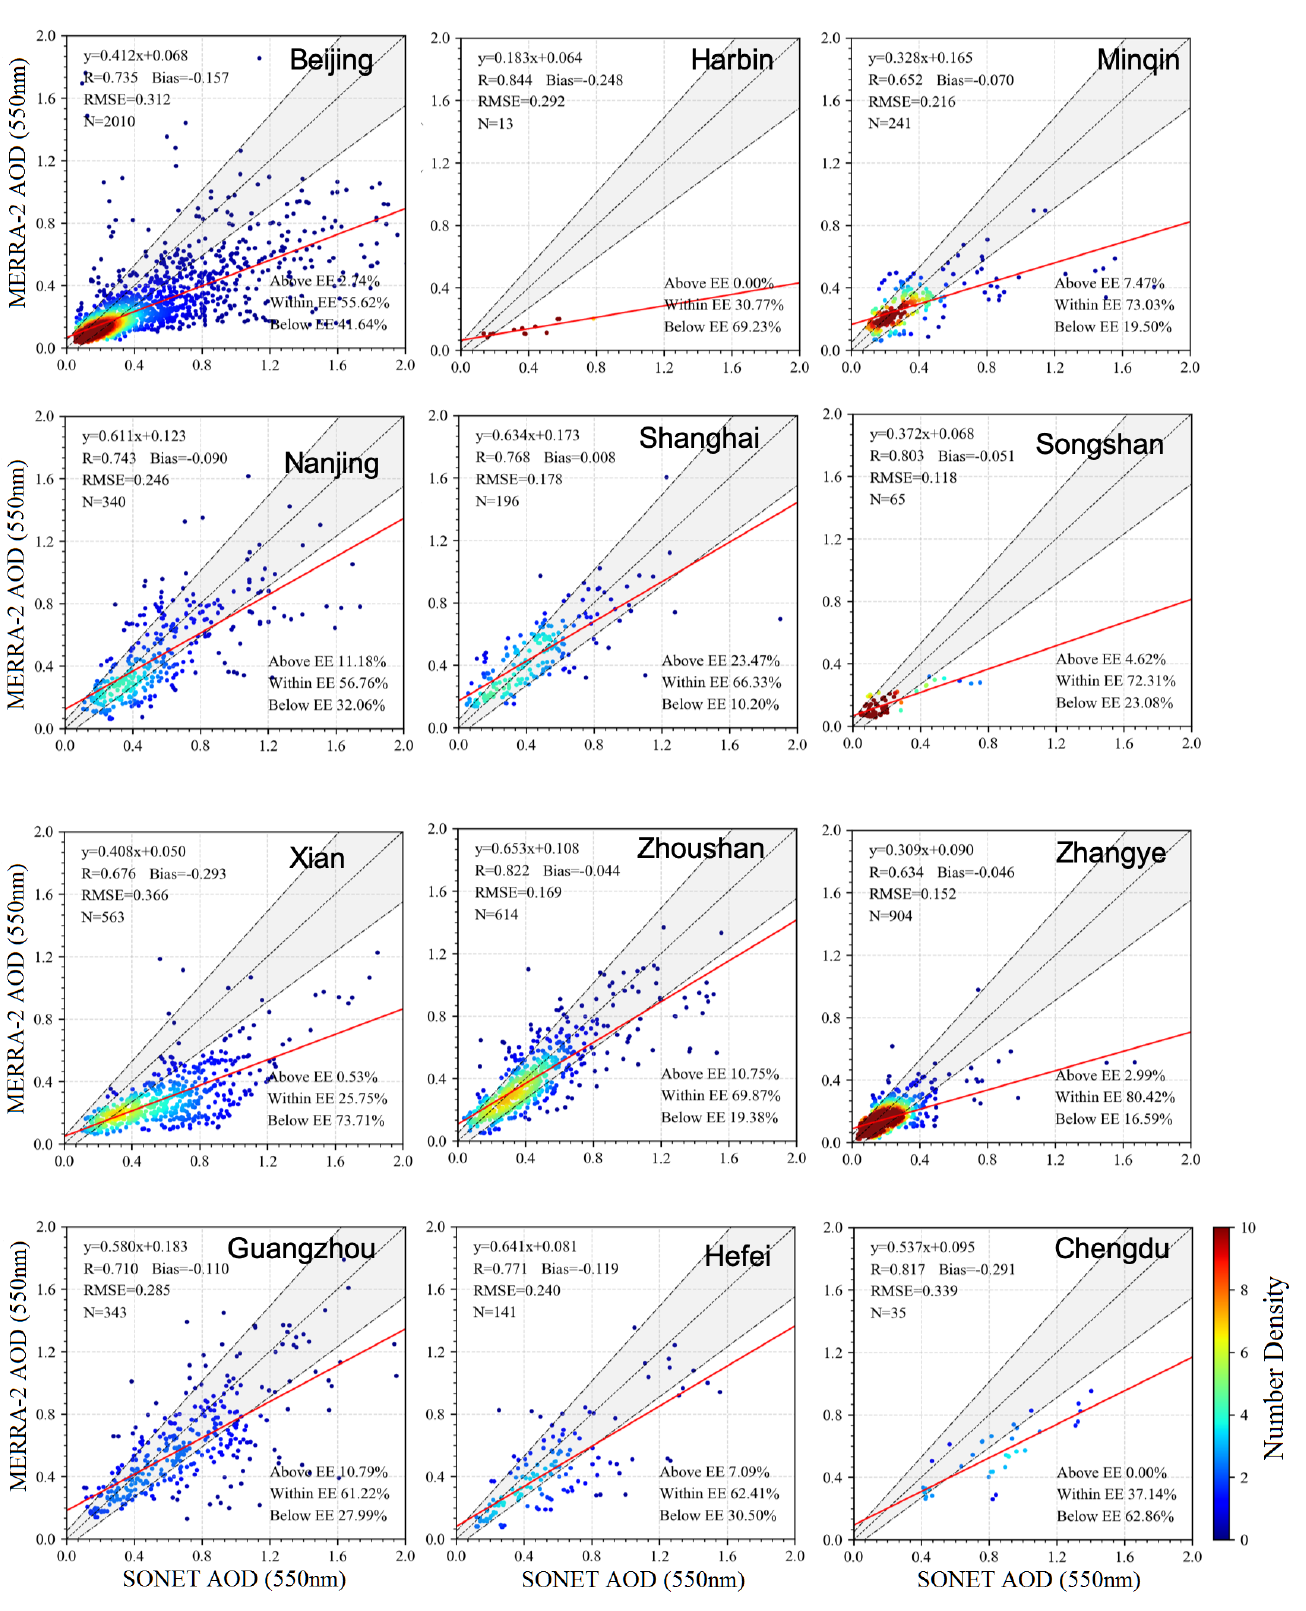
Figure 2. Validation of MERRA-2 AOD (550 nm) with SONET measurements at 12 sites over China. The grey dashed line represents the one-to-one line and EE line. The red solid line represents the linear fitting line.